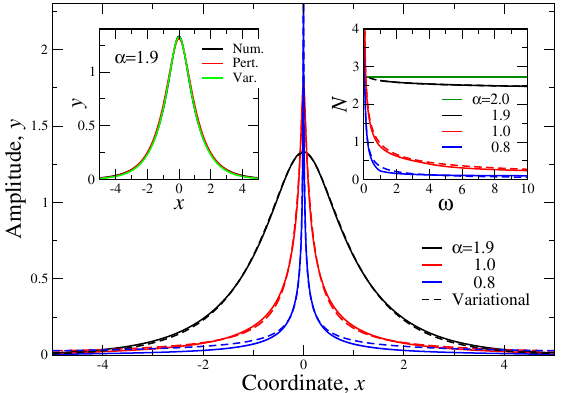
Figure 3. Main panel. Comparison of numerical (full lines) and variational (dashed lines) solutions of the fractional soliton equation (7) for different Lévy indices α , coded by colors and shown in the legend. Here, 1 and 1 , see Eq. (42). Left inset. Comparison of numerical (black), χ without loss of generality, we put ω = | | = 1.9 ( ε 0.1 , Eq. (13)). All three curves are perturbational (red) and variational (green) solutions of (7) for α = = almost indistinguishable in the scale of the plot. Right inset reports the comparison of numerical and variational (39) (with the trial function in the form of (9)) dependencies N (ω) . Full lines—numerical curves, dashed lines— variational. The values of Lévy indices α are shown in the